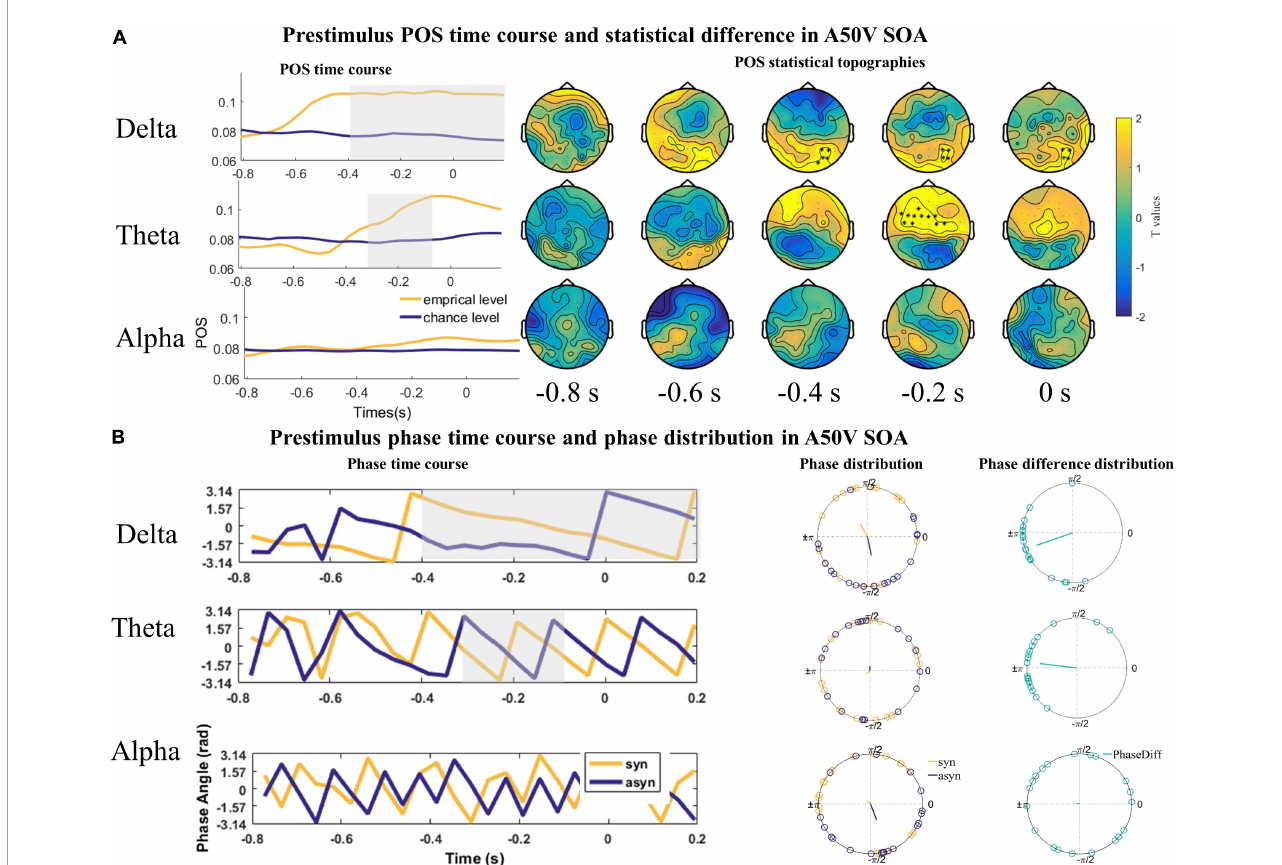
FIGURE4 The statistical difference of phase opposition sum (POS) in the A50V stimulus onset asynchronous (SOA). (A) Left is the time course of empirical and chance level POS in the delta, theta, and alpha band respectively. Time 0 s indicates the onset of auditory signals. Two positive significant clusters were found in the delta and theta bands. Each topography shows the average t-map across a 200 ms temporal window starting at the indicated time point. (B) The time courses of phases extracted from and averaged over the cluster (delta and theta) or the whole channels (alpha) across subjects were shown on the left. The mean phases and phase differences are plotted for each participant in the delta, theta, and alpha band on the right. The orange, blue, and green lines indicate the mean resultant vector lengths (MRVLs). Gray-shaded areas indicate the timeframes with significant differences. Significant channels are highlighted with